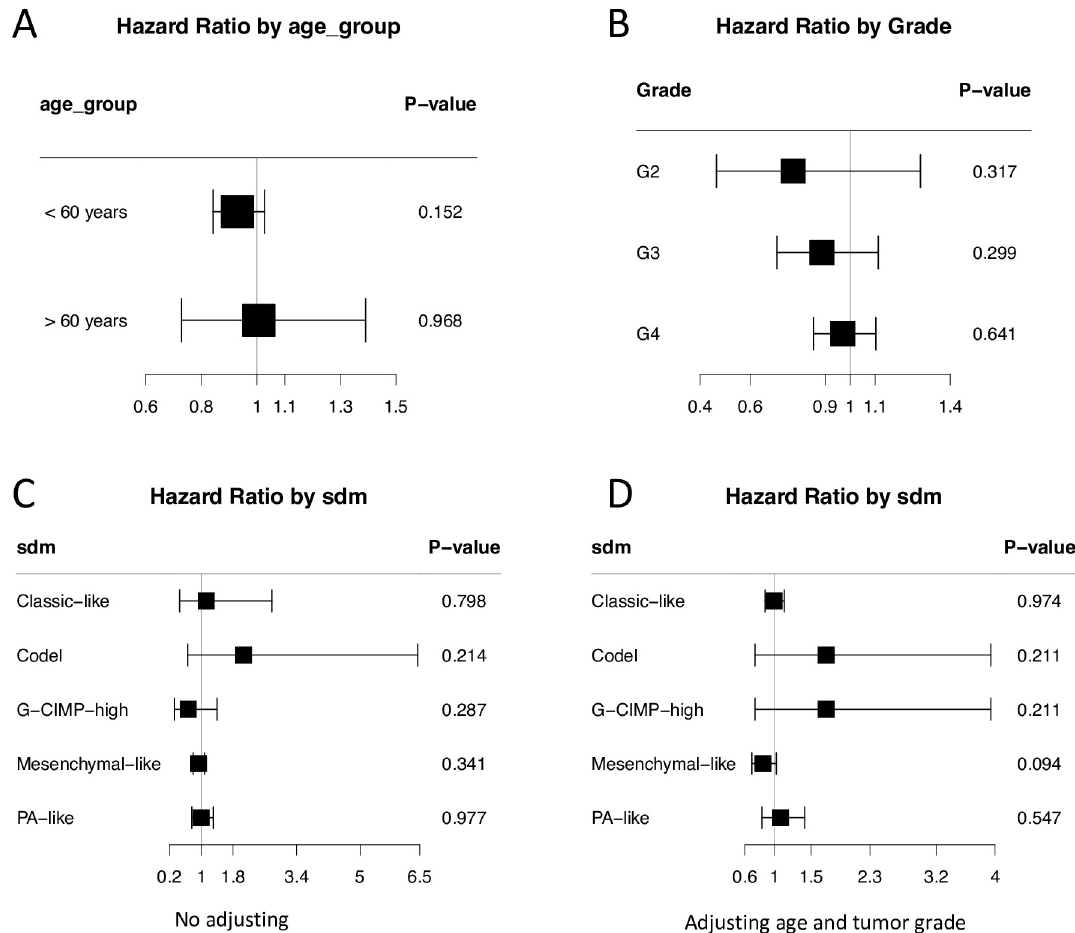
Fig 4. Forest plot shows the association of age acceleration with patient overall survival in each subgroup. (A) Age group. (B) Tumor grade. (C) Molecular subtype without adjusting. (D) Molecular subtype adjusting for age and tumor grade.